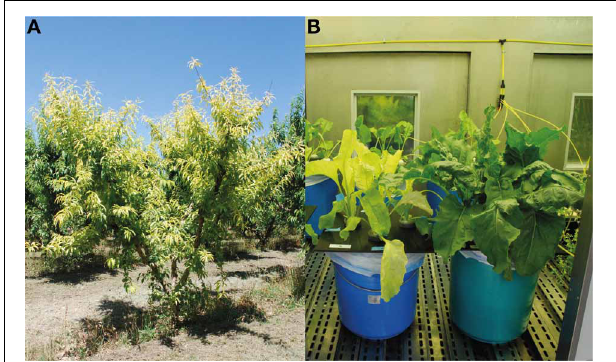
FIGURE 1 | (A) Iron-deficient peach trees grown in the field. (B) Sugar beet plants grown in hydroponics. Sugar beet plants were grown in Fe-deficient (left side) or Fe-sufficient (right side)